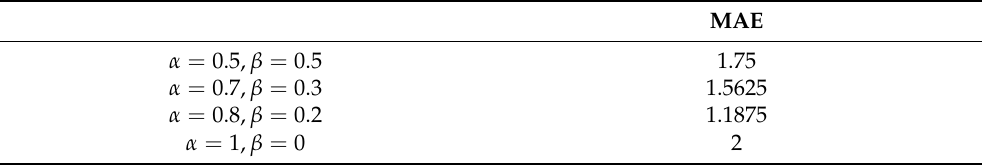
Table 7. Results of prediction models under different hyperparameters at the late growth stage of leafy